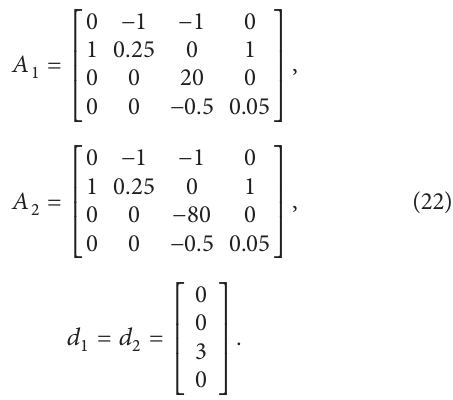
Figure 4: The errors between states and their estimated.